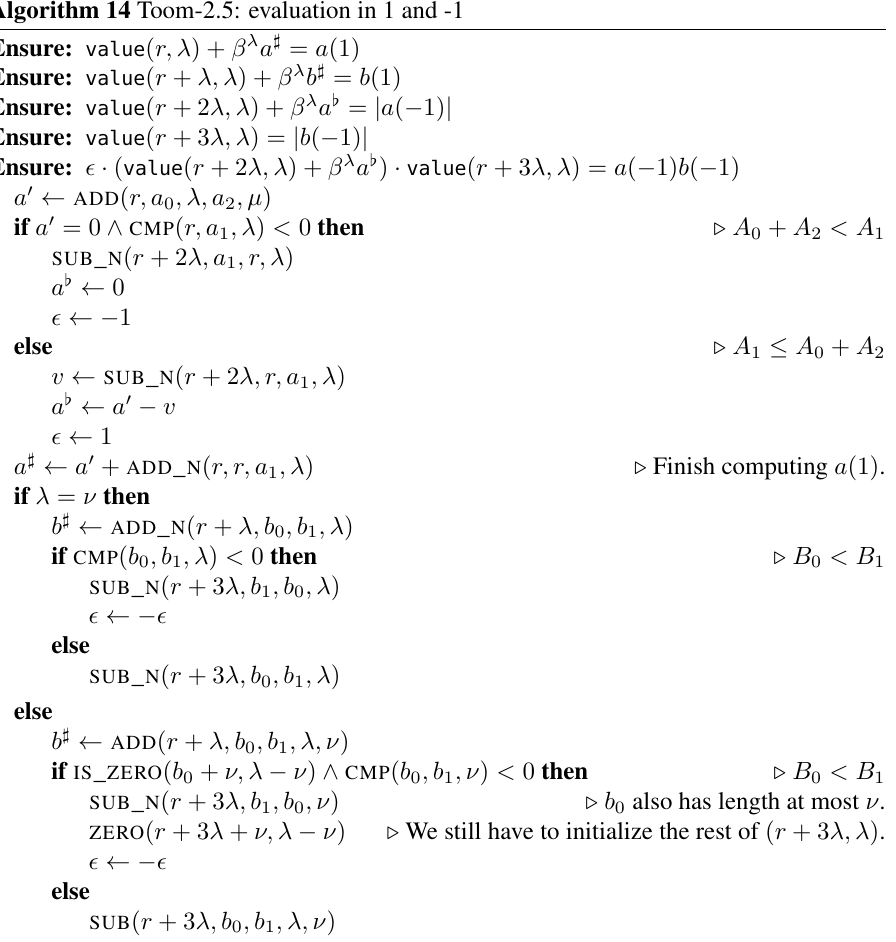
Algorithm 14 Toom-2.5: evaluation in 1 and